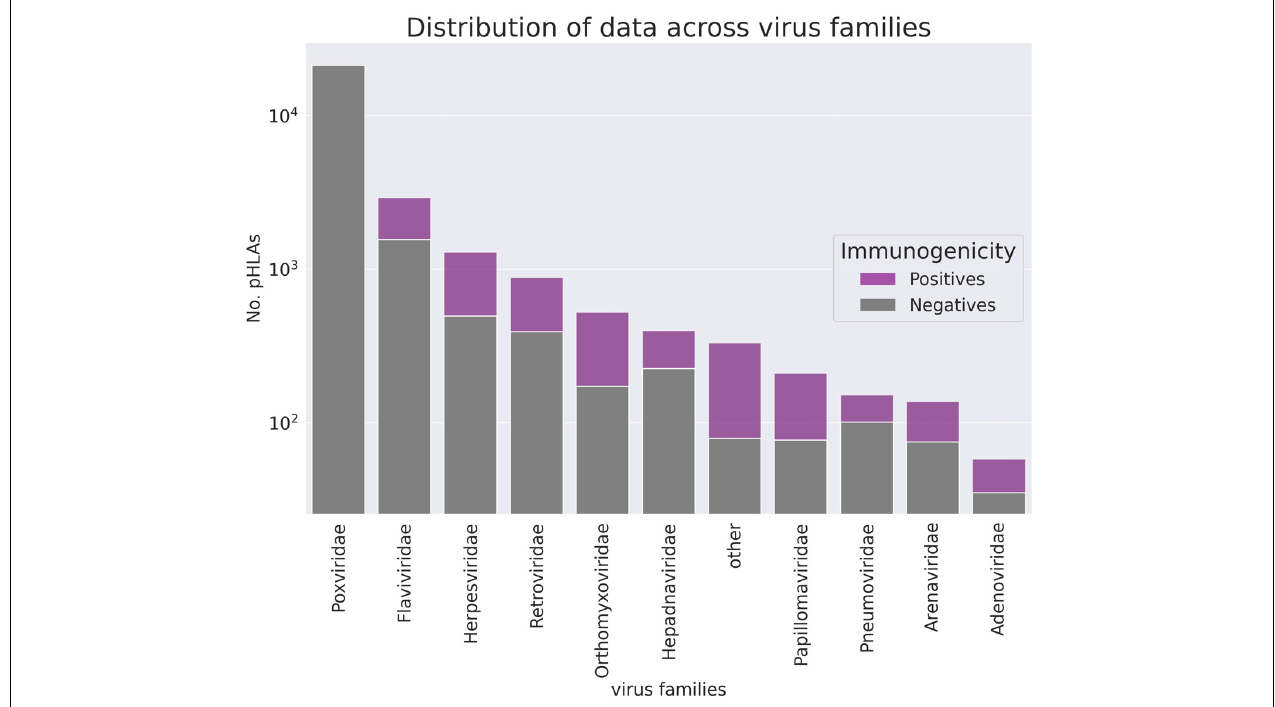
FIGURE 2 | The number of pHLA complexes with confirmed immunogenicity in the curated database per virus family (logarithmic scale). Families counting less than 55 observations are aggregated in the “other”